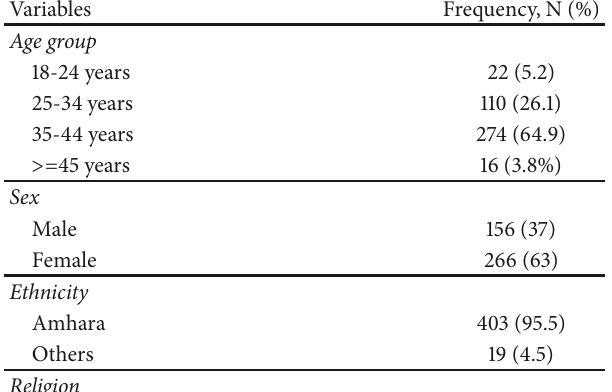
Table 1: Sociodemographic characteristics of study participants at selected hospitals ART clinics, North Shewa Zone, Amhara regional state, Ethiopia, 2017 (n=422).